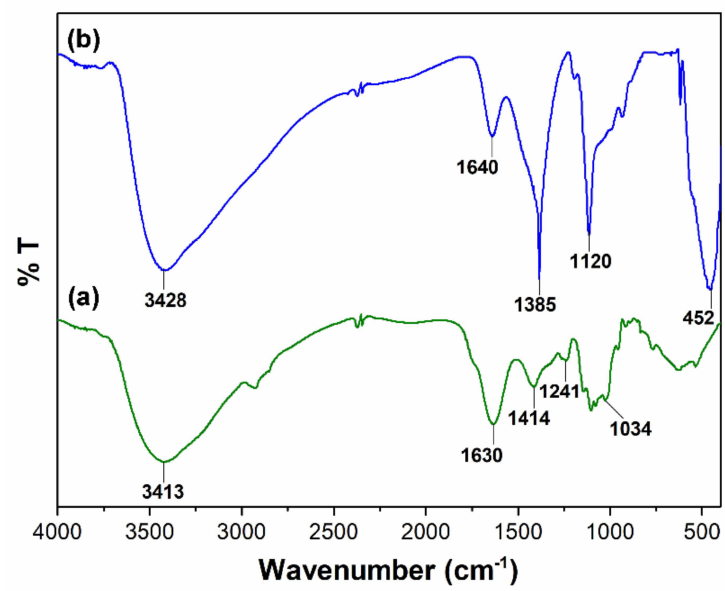
Figure 8. FTIR spectra of ( a ) M. calabura extract and ( b ) CuO